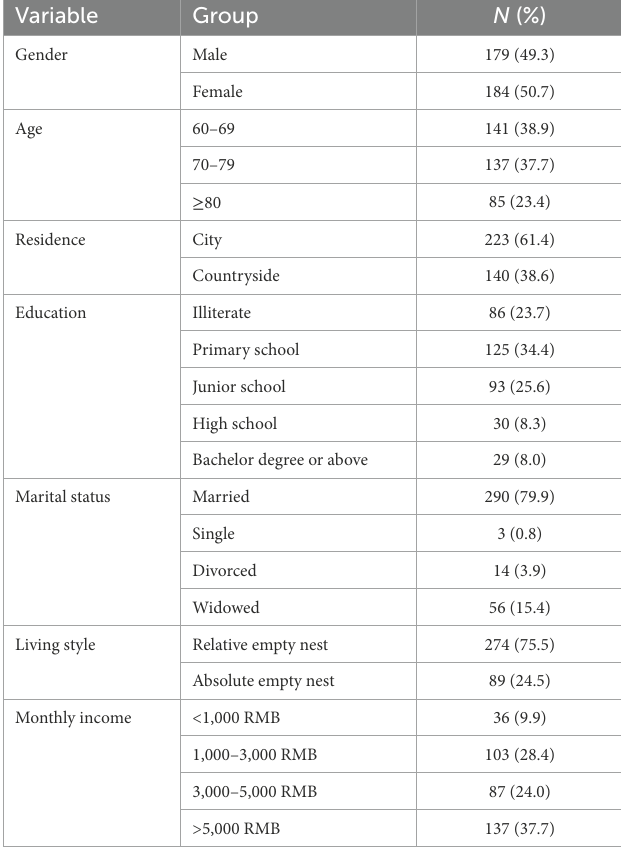
TABLE 1 Demographic characteristics of the participants ( n =